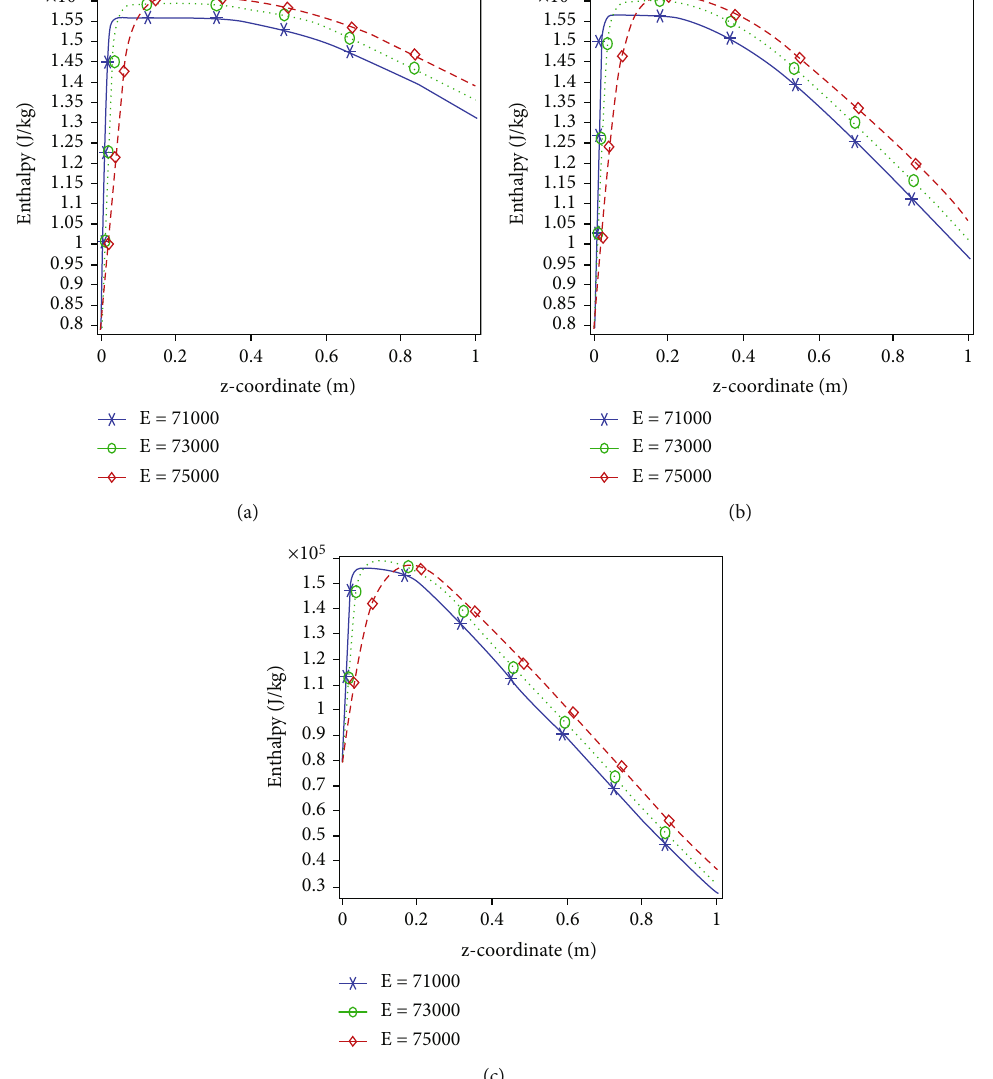
Figure 13: Measurement of enthalpy at upstream along the backward step channel against the axial direction at (a) Re = 100 , I : C = 3 % , a = 0 : 5 ; (b) Re = 100 , I : C = 3 % , a = 0 : 6 ; and (c) Re = 100 , I : C = 3 % , a = 0 : 7